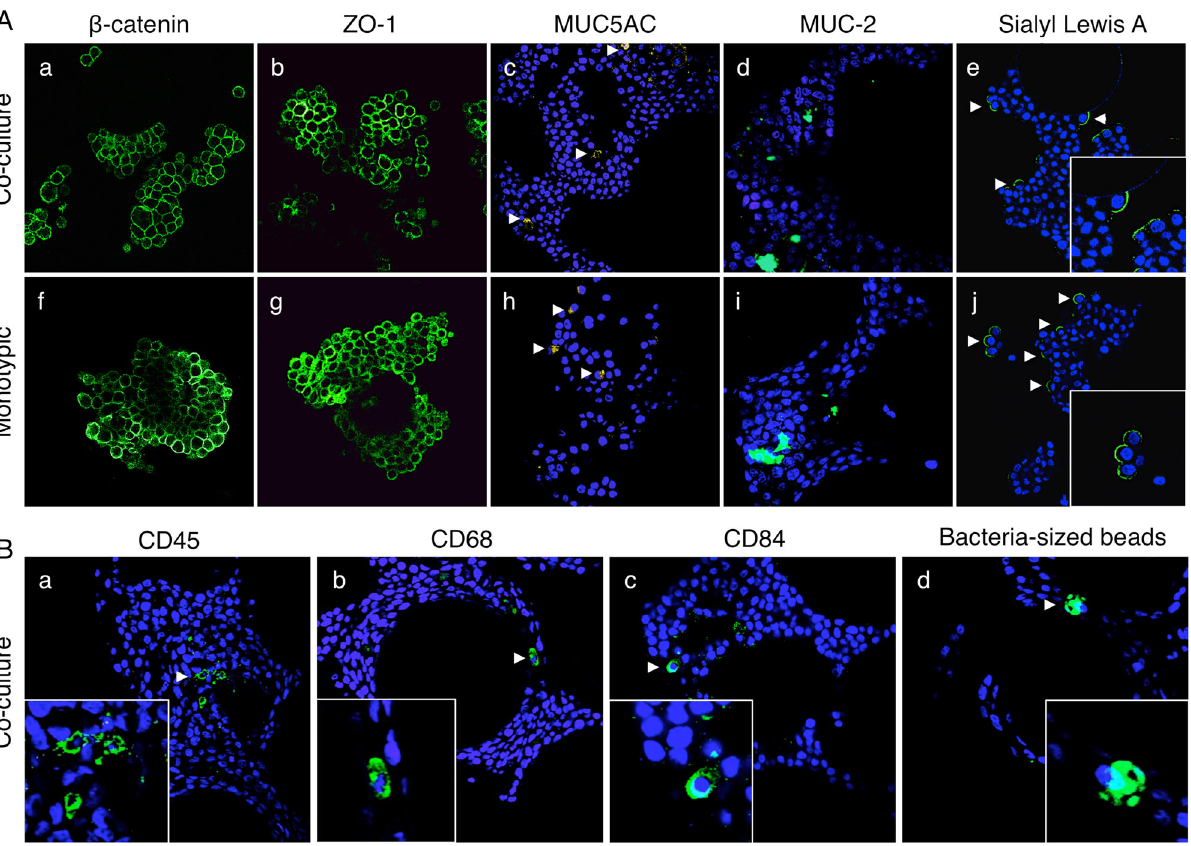
Fig. 2 3-D co-culture model validation. A Adherens and tight junction markers β -catenin ( a , f ) and ZO-1 ( b , g ); mucin markers MUC5AC ( c , h ) and MUC2 ( d , i ); and M cell marker Sialyl Lewis A ( e , j ) shown in green . Cell nuclei were stained with DAPI ( blue ; c – e and h – j ). B U937 macrophages within the 3-D co-culture model. Antibodies used to label macrophages shown in green : a anti-CD45, b anti-CD68, and c anti- CD84. Cell nuclei stained with DAPI ( blue ). d Internalization of bacteria-sized fl uorescent beads by phagocytic U937 macrophages. The 3-D epithelial model was used as a negative control (Supplementary Fig. S1). Magni fi cation = 400×. Arrowheads are guides for select